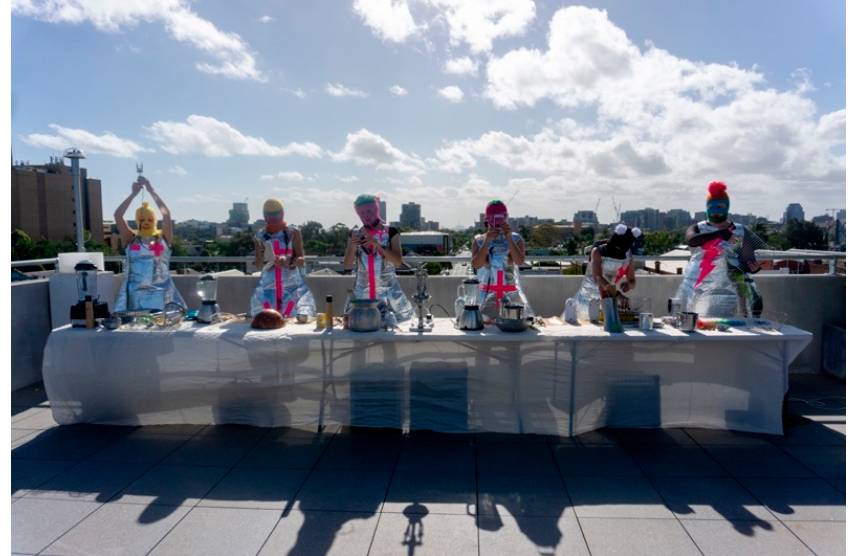
Figure 1. A Public Kitchen performed by Sonic Electric at MARS Gallery, Melbourne, Australia, 2019.